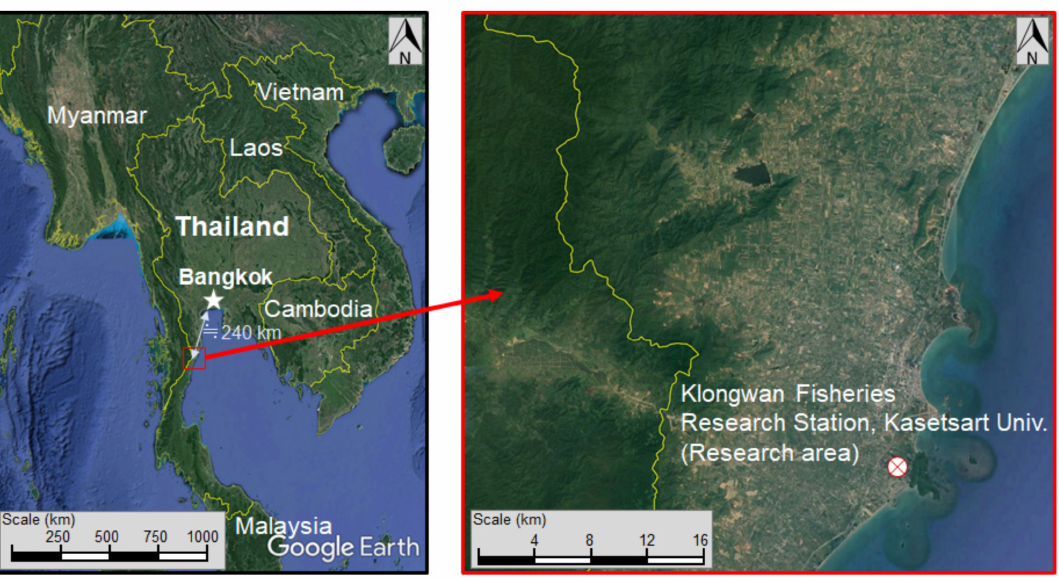
Figure 1. Observation